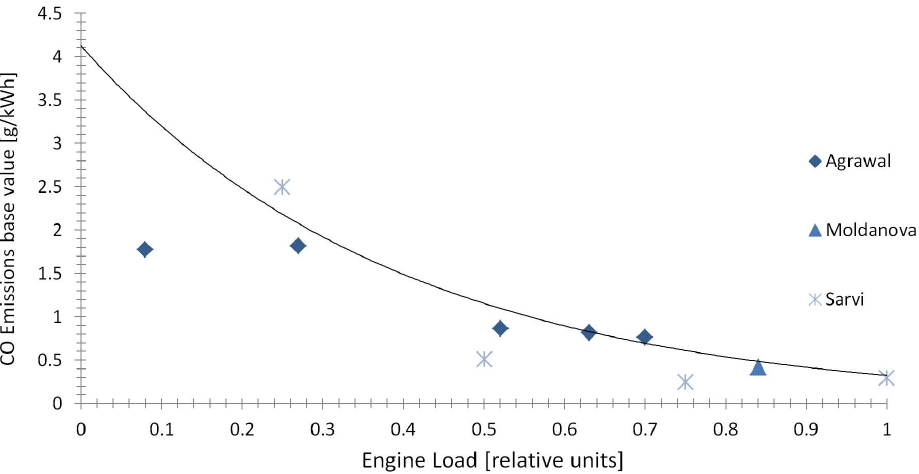
Fig. 6. The base value of CO-emission as a function of relative engine load. The measurements of Agrawal, Moldanova and Sarvi have been shown, and the CO-base emission factor curve is based on Sarvi (2008a). The emissions of CO are also influenced by rapid changes of relative engine